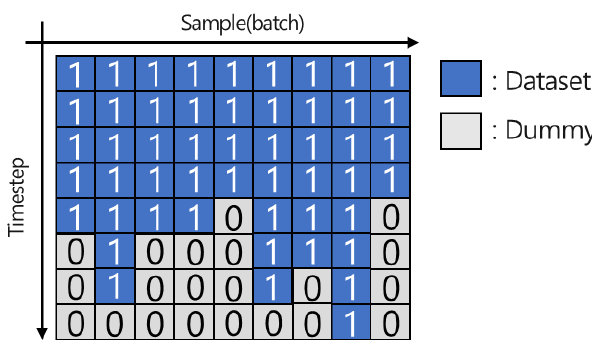
Figure 3. Example of weight matrix of the masking method.